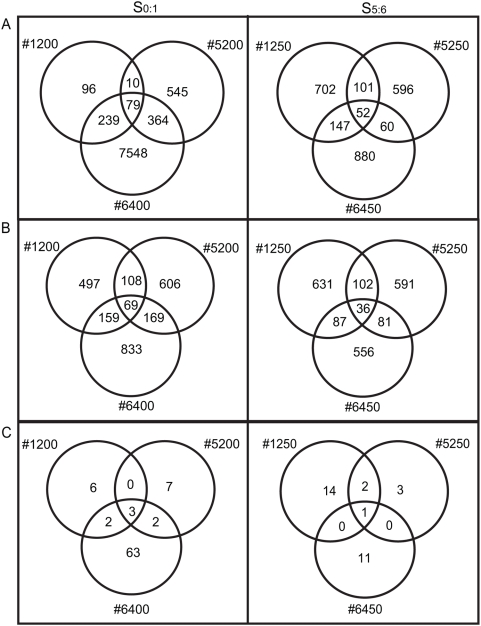

Venn Diagrams Summarizing the Number of Differentially Expressed Genes Detected in Each Allopolyploid at the S0∶1 and S5∶6 Generations.The number of differentially expressed genes detected in the S0∶1 and S5∶6 generations (left and right panels, respectively) under the A) per-gene variance ANOVA model, B) common variance ANOVA model, and C) intersection of the per-gene and common variance models.